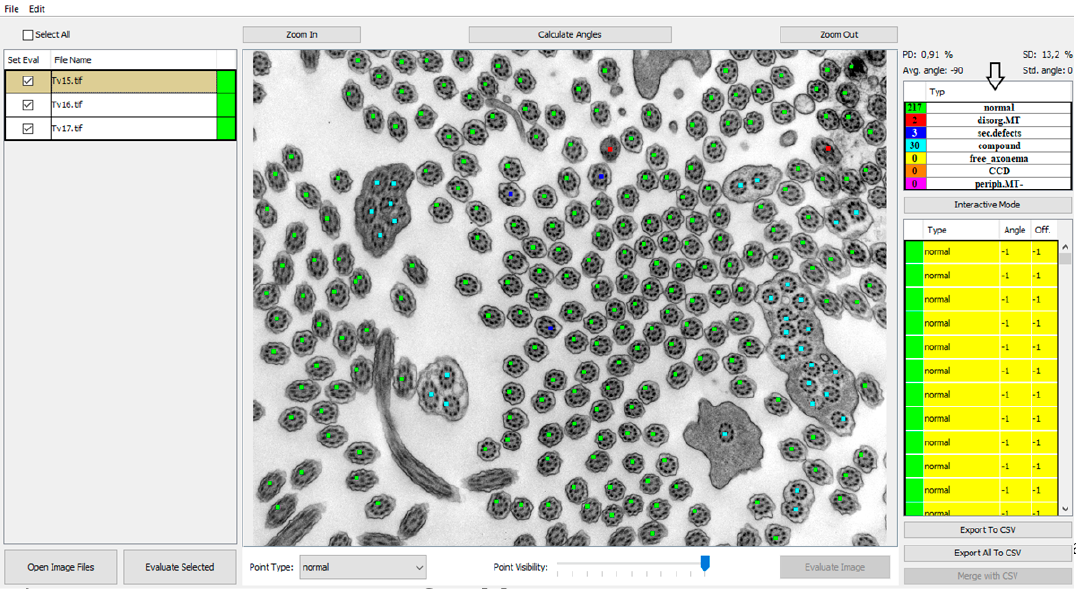
Figure 5. Image displays the possibility of adding other classes necessary for precise identification of primary and secondary defects. The classes are visible in the right top panel (arrow).